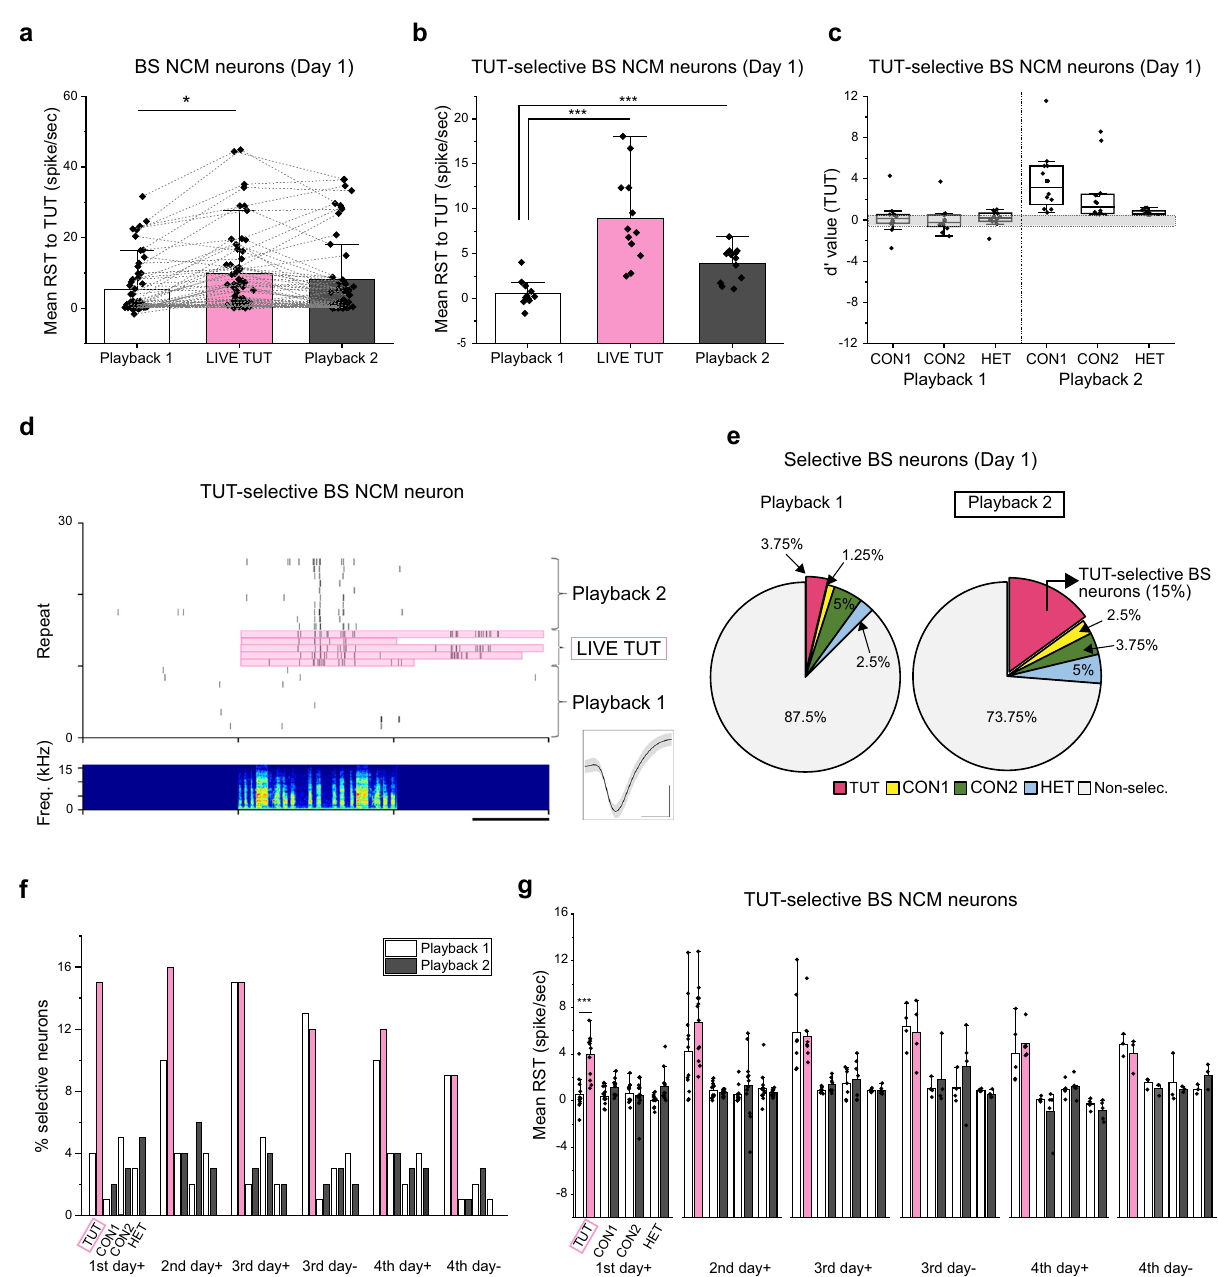
Fig. 2 | NCM neurons increase auditory responsiveness to tutor song playback aftersocial interaction witha singing tutor. Meanresponse strength (RST) of all BS NCM neurons ( a ) or TUT selective BS neurons ( b , g ) to tutor song playback (Playback 1 and 2), tutor singing (LIVE TUT) ( a , b ) or playback of different songs before(Playback1)andafter(Playback2)hearingLIVETUT(+)orbeingexposedto a silent tutor ( − ) throughout four days of tutoring ( g ). c Mean d-prime values for TUT over other song stimuli of TUT selective BS neurons before (Playback 1) and after (Playback 2) hearing LIVE TUT. The boxes show the 25 – 75%, the center lines are de fi ned by the medianand open squares by the mean. The whiskersincludeall data points within 1.5 IQR (Interquartile range) and the ‘ outsider ’ dots are the data pointsthatfalloutsidethewhiskerline.Grayareasindicatenon-selectiveresponses ( − 0.5< d ’ value<0.5). d Raster plots of spiking activity of TUT-selective BS NCM